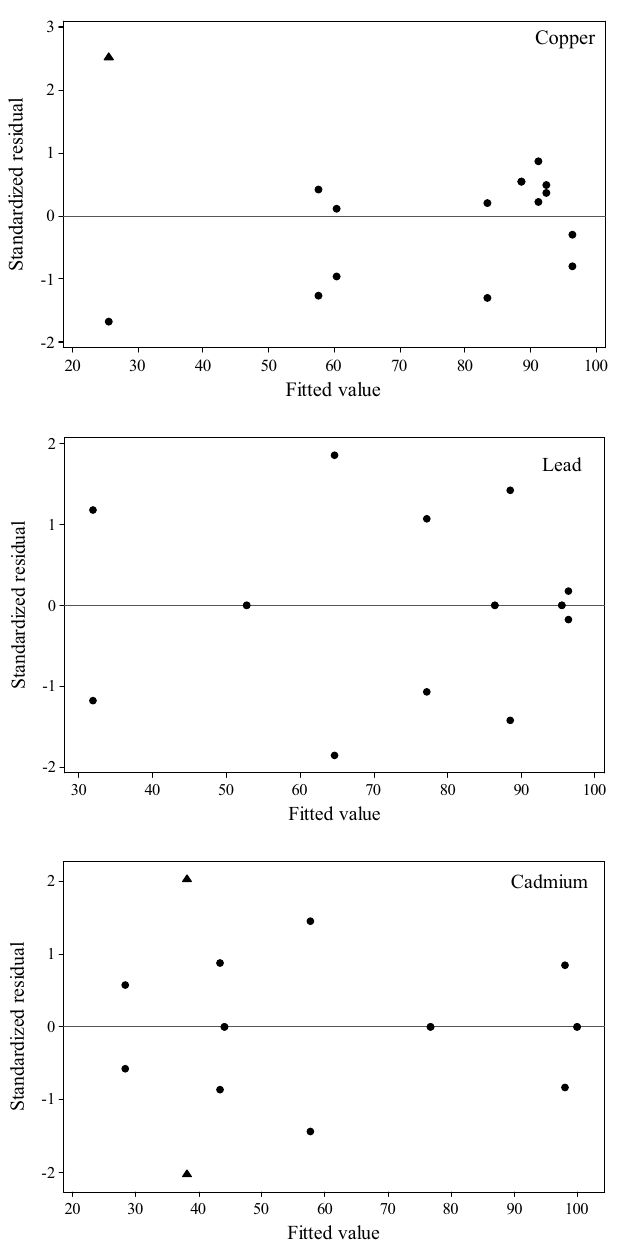
Figure 4. Removal efficiency for Cu 2+ , Pb 2+ and Cd 2+ (predicted) versus residual. Filled black triangle: